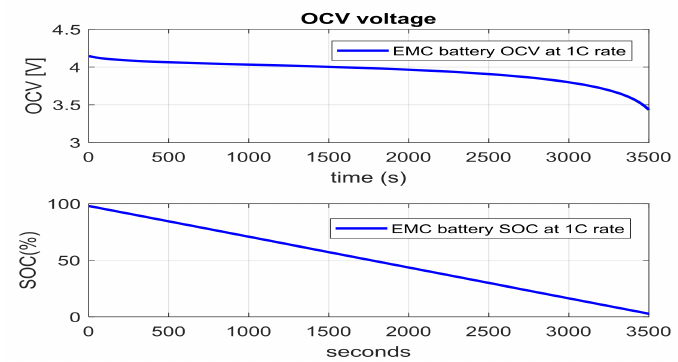
Figure 8. The Li-Ion battery 2RC EMC OCV curve during a complete discharging cycle at 1 C rate ( top ) and the corresponding Li-Ion battery SOC ( bottom ).